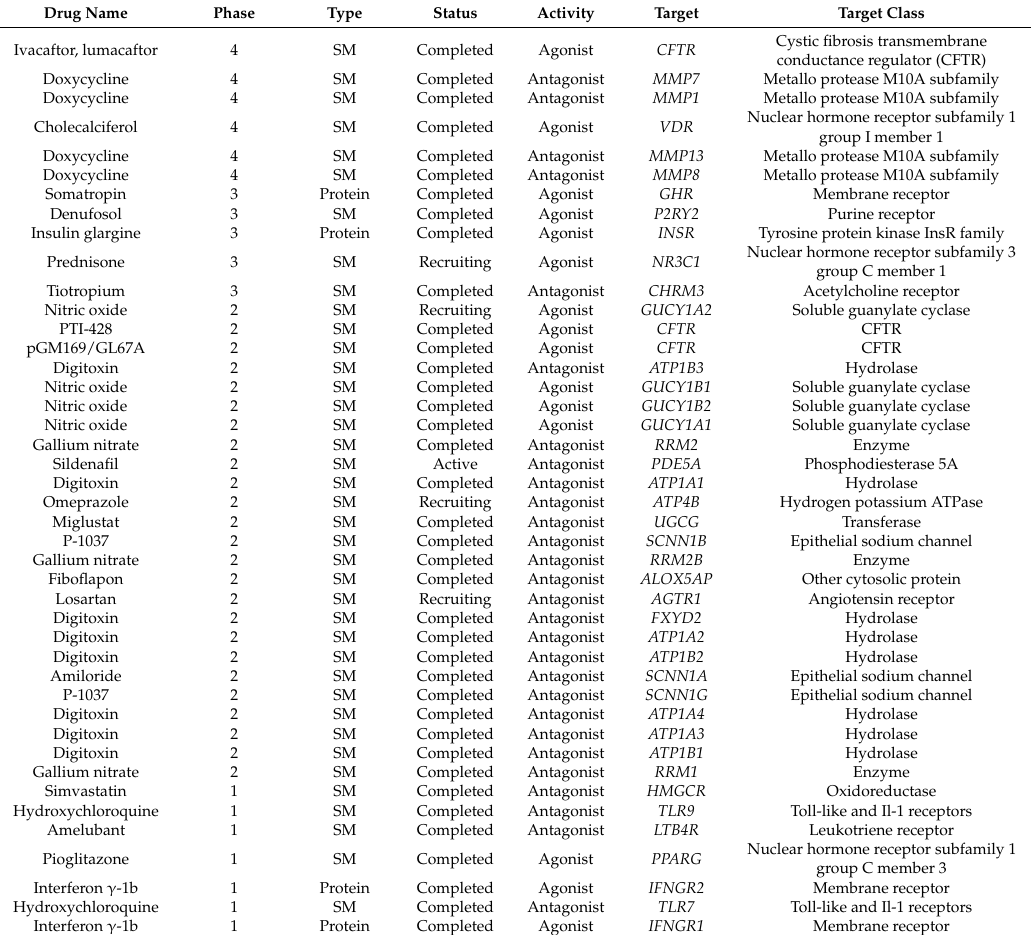
Table 3. Gene targets and therapeutic